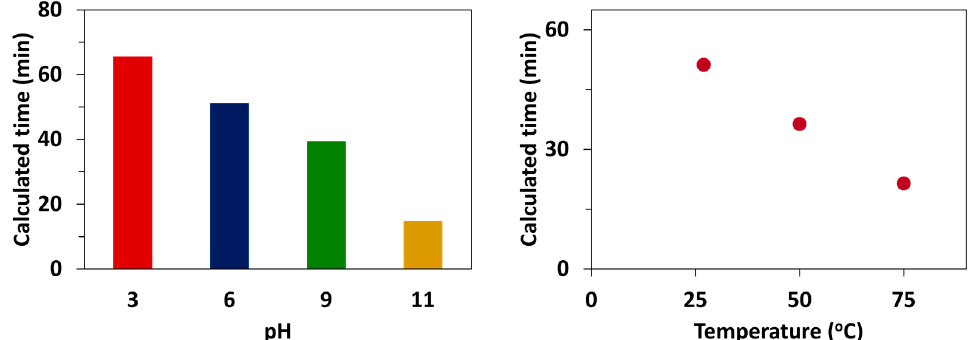
Figure 11. Calculated time of MB degradation using different pH levels ( left ) and temperatures ( right ). Reaction conditions: [catechol-HCP-Fe] = 1 g/L, [H 2 O 2 ] = 0.5 M, [MB] = 100 ppm, pH = 6 (neutral pH) or as specified, room temperature (27 °C) or as specified.